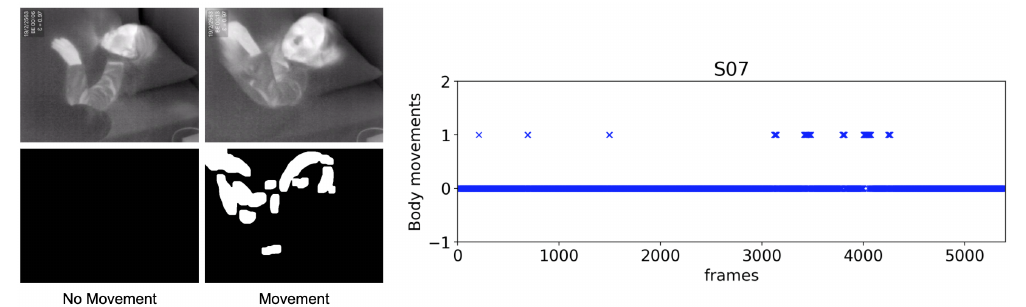
Figure 5. Sample output of the body movements